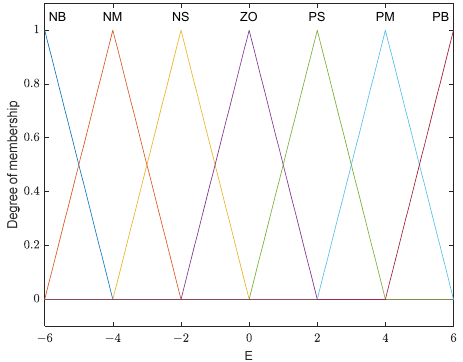
Figure 7. Triangular membership function.